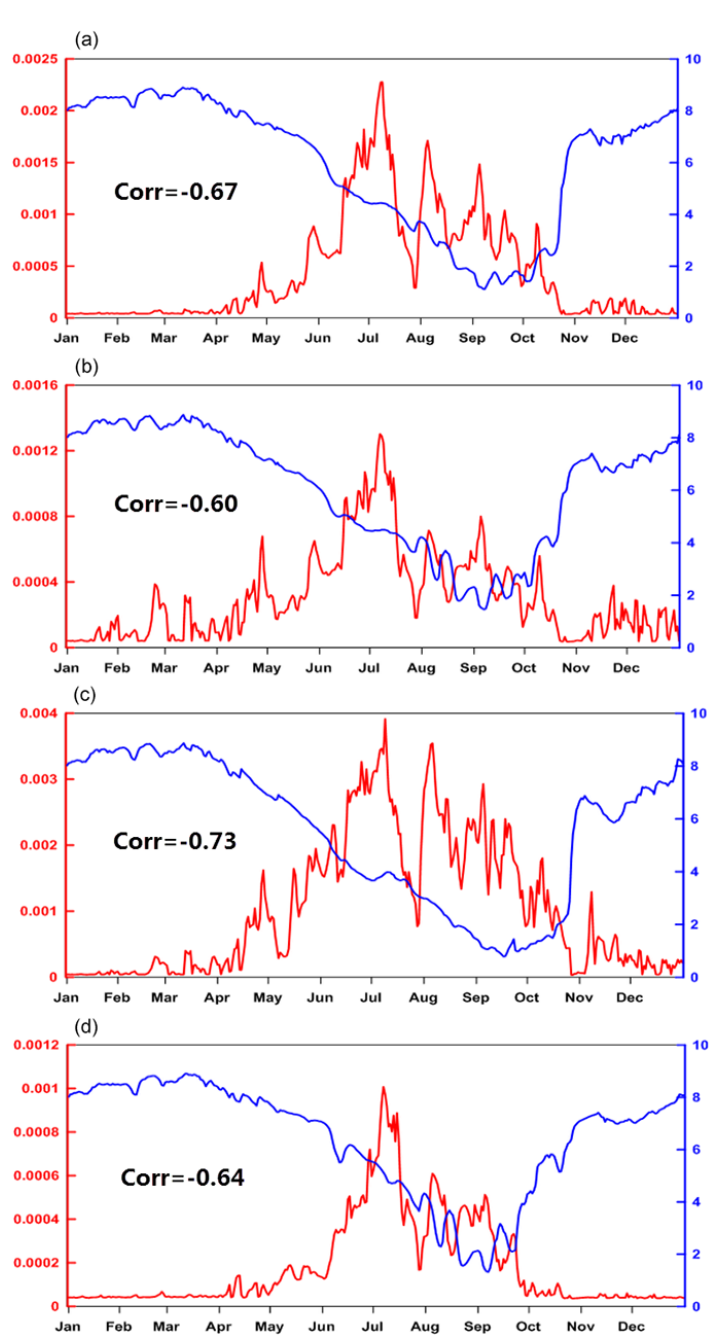
Figure 9. The correlation between the bottom dissolved oxygen concentration and N 2 at the station of 123 ◦ E, 31 ◦ N. The blue curve repre- sents the bottom dissolved oxygen concentration, and the red curve represents N 2 . (a–d) The base run, Q const , Q 2 , and Q 0 . 5 ,